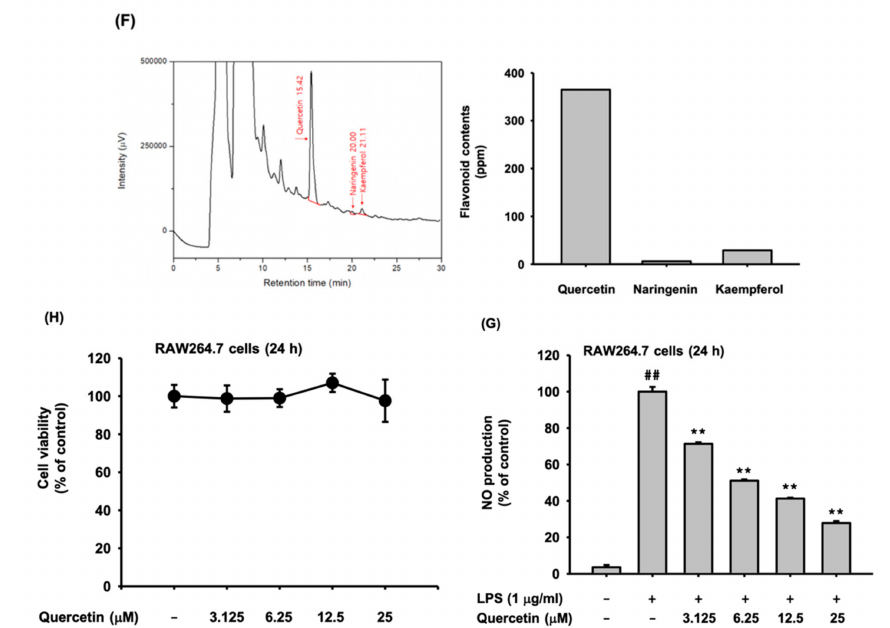
Figure 1. In vitro anti-inflammatory e ff ects of Potentilla glabra Var. mandshurica (Maxim.) Hand.-Mazz ethanol extract (Pg-EE). ( A ) The nitric oxide (NO) production level in the culture supernatant of RAW264.7 cells treated with lipopolysaccharide (LPS) (1 µ g / mL) (upper panel), Pam3CSK4 (200 µ g / mL) (middle panel), or Poly(I:C) (10 µ g / mL) (lower panel), with or without Pg-EE for 24 h, was analyzed with a Griess assay. ( B , C ) RAW264.7 cells and HEK293T cells were treated with indicated concentrations of Pg-EE (0–150 µ g / mL) for 24 and 48 h and determined using the (3-4,5-dimethylthiazol-2-yl)-2,5-diphenyl-tetrazolium bromide (MTT) assay. ( D , E ) RAW264.7 cells were treated with various concentrations of N(G)-Nitro- l -arginine methyl ester (L-NAME) (0–2 mM) for 24 h. The NO production level in the culture supernatant of RAW264.7 cells treated with LPS was analyzed with a Griess assay, and the cell viability was detected with the MTT assay. ( F ) The contents of Pg-EE were detected by high-performance liquid chromatography (HPLC) analysis using standard flavonoids (quercetin, naringenin, kaempferol, silibinin, genistein, and apigenin). ( G , H ) RAW264.7 cells were treated with various concentrations of quercetin (3.125–25 µ M) for 24 h. The NO production level